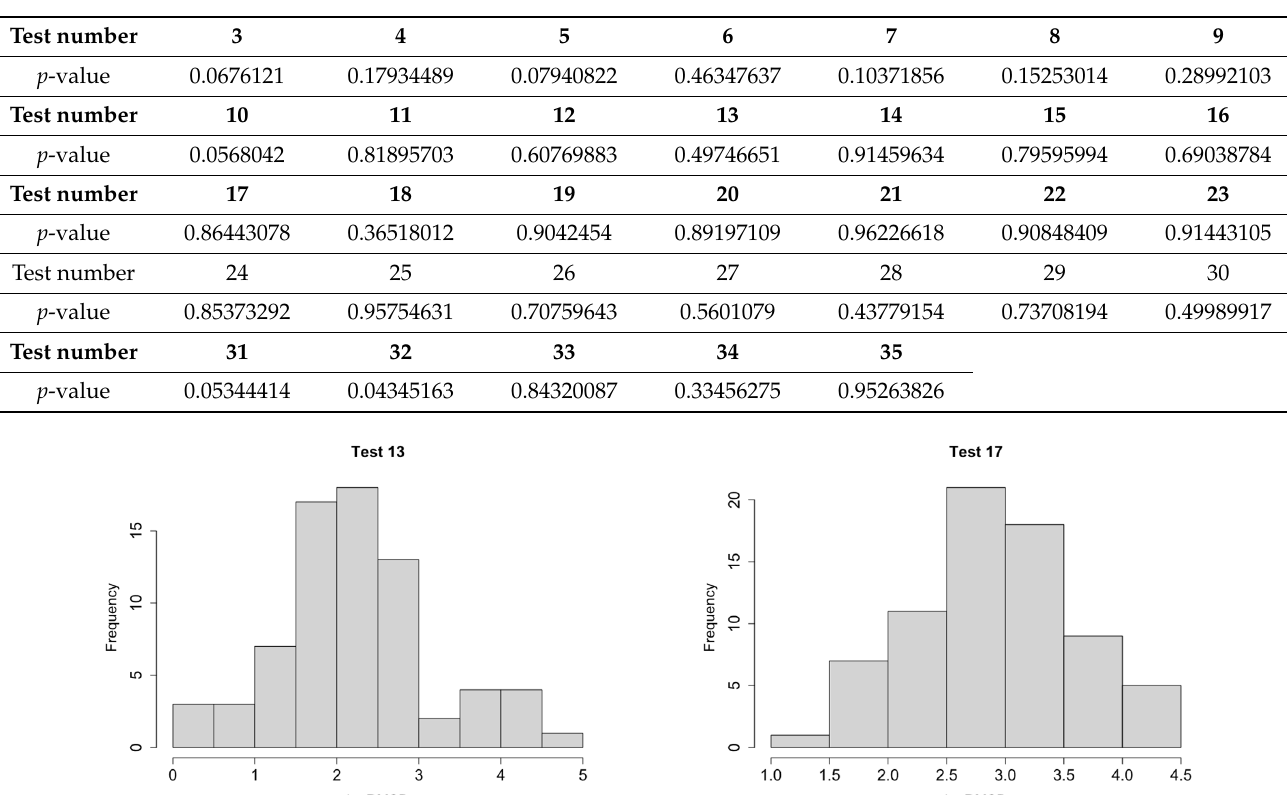
Table 2. Kolmogorov-Smirnov test.